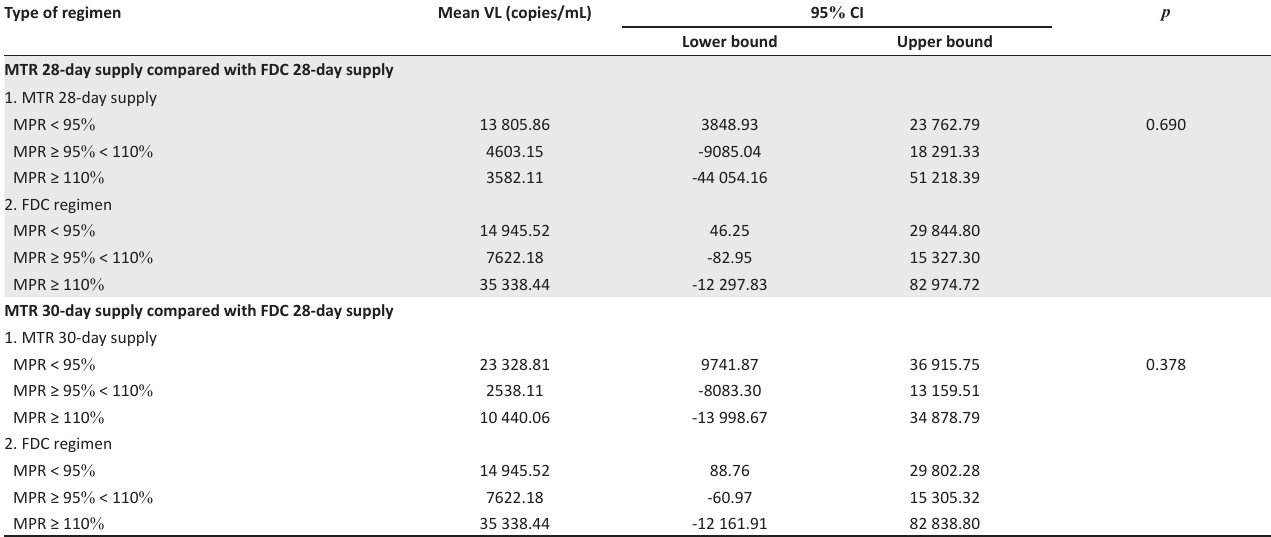
TABLE 5: The effect of regimen type and adherence categories on viral load. Type of regimen